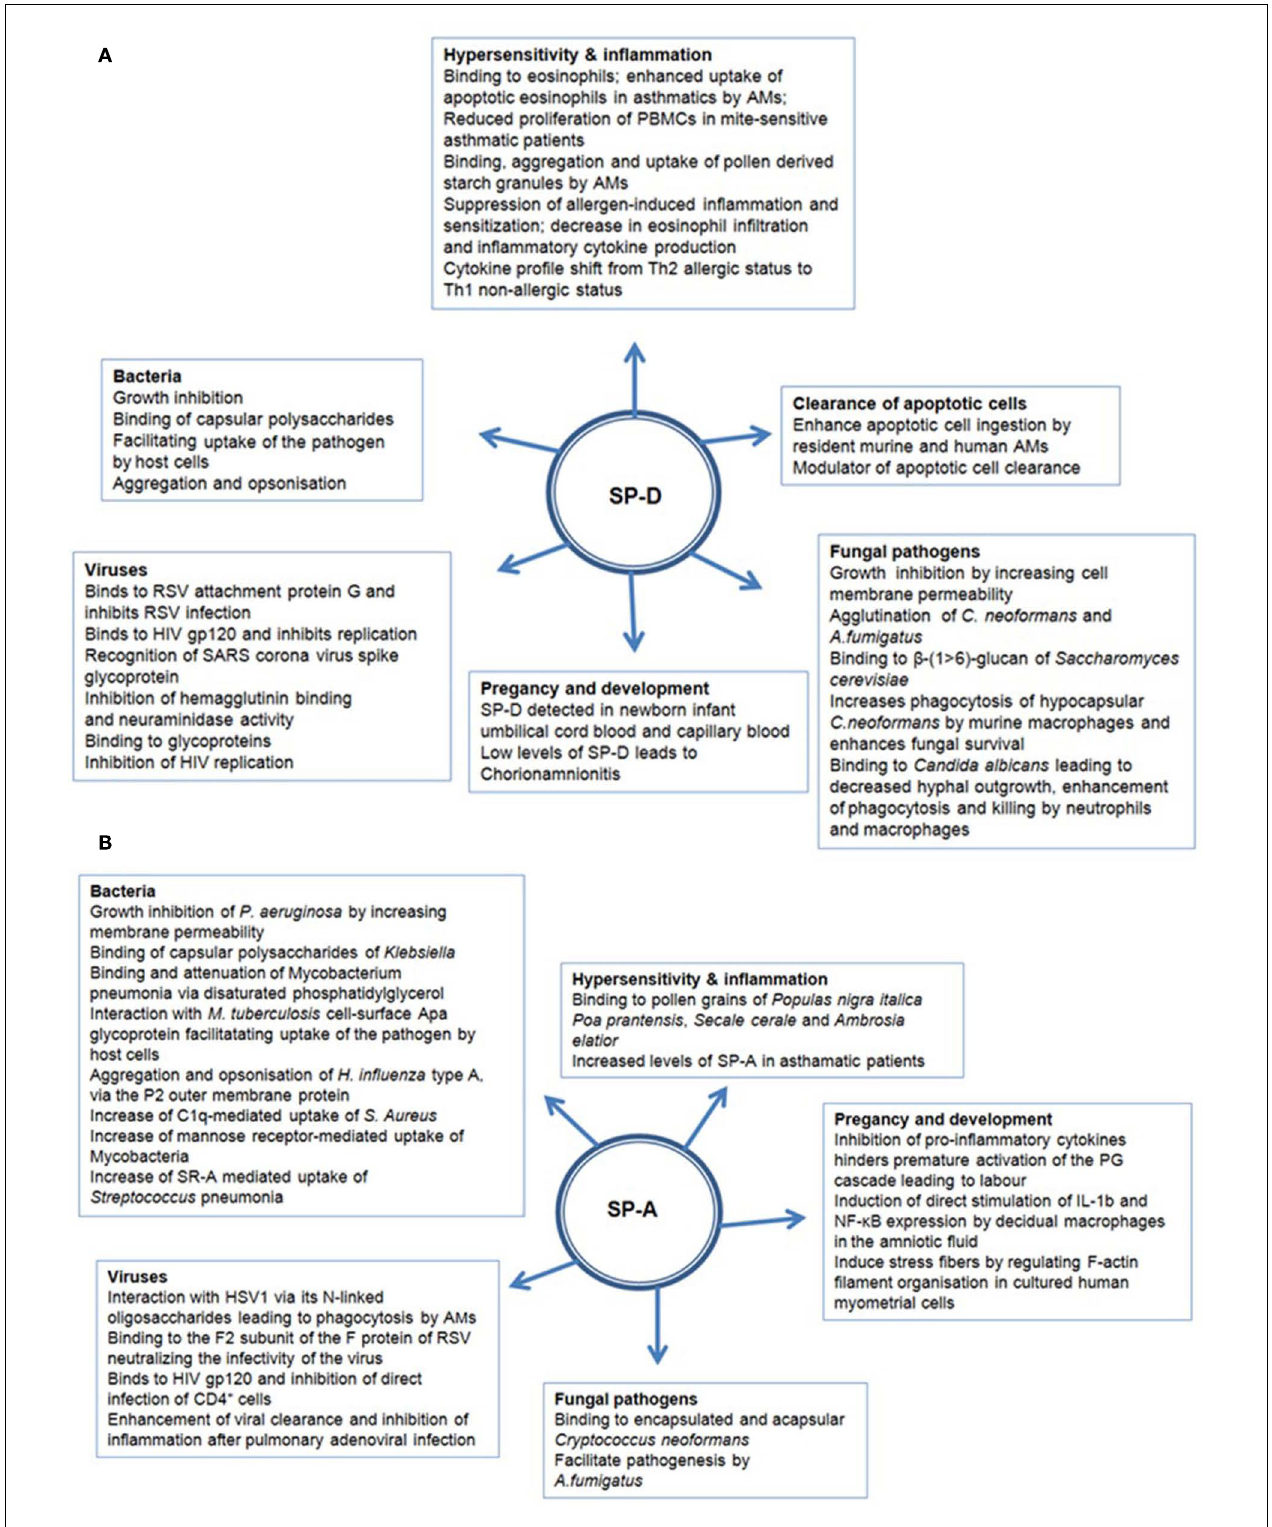
FIGURE 2 | Multiple functions of (A) SP-D and (B) SP-A in human health and disease.